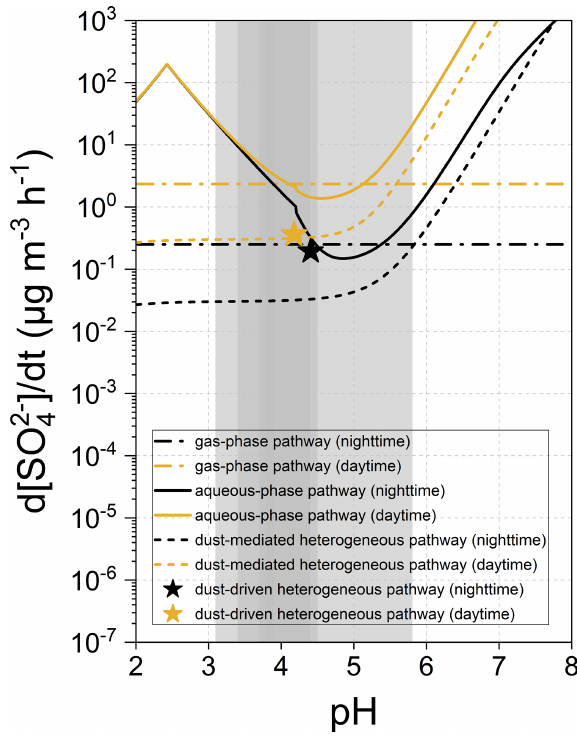
Figure 7. Formation rate of sulfate attributed to the gas-phase, aqueous-phase, and dust heterogeneous pathways as a function of particle acidity (pH). Grey areas indicate the pH ranges of the pol- luted particulate matters, with darker ones being more common (Ding et al., 2019).